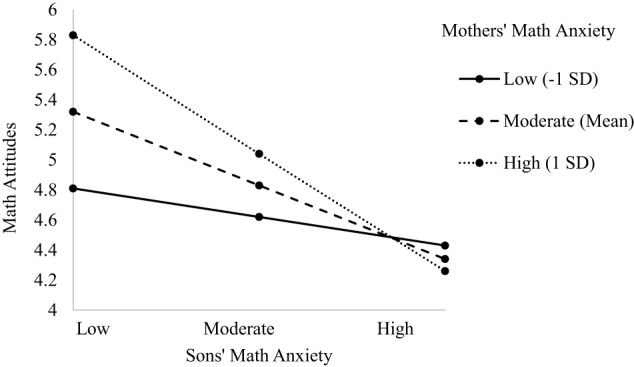
Three-way interaction predicting math attitudes from Mothers' and Sons' math anxiety.